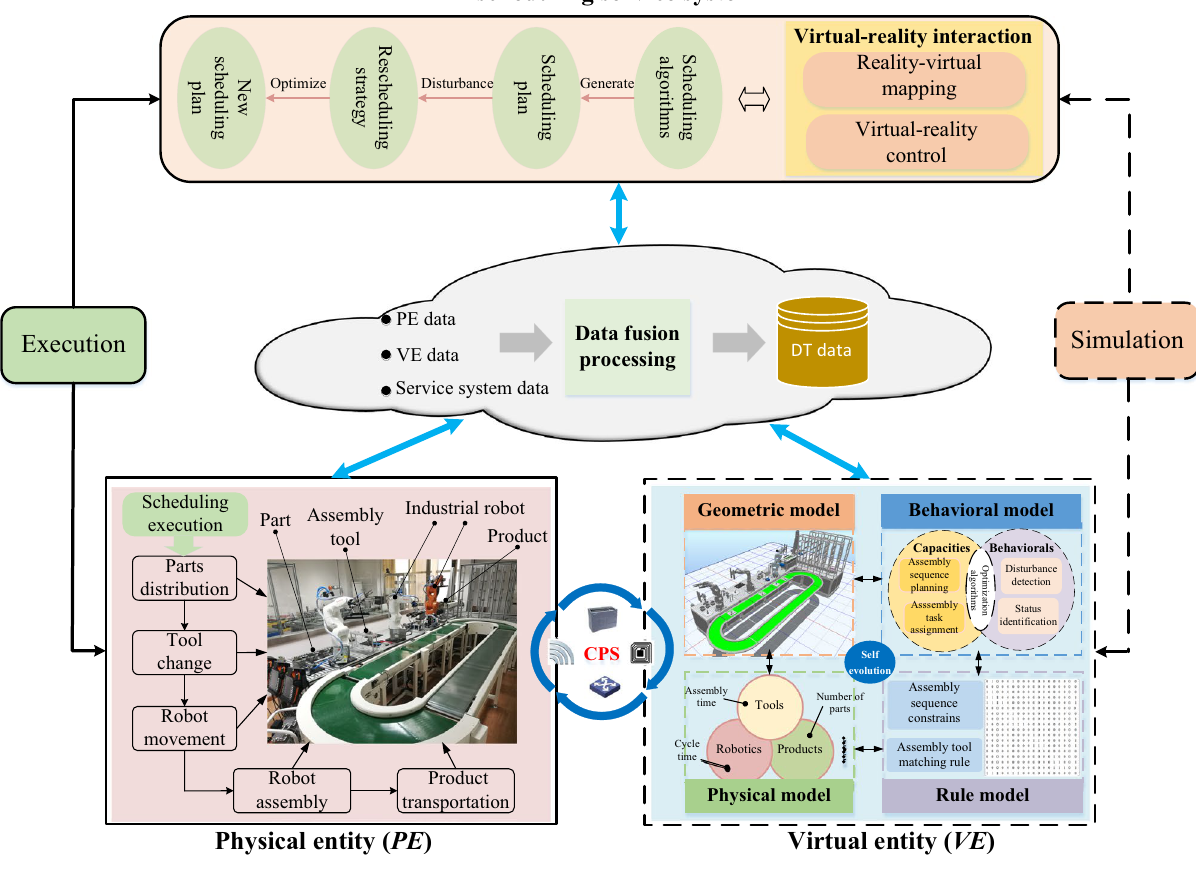
Figure 1. Framework of DT-based task